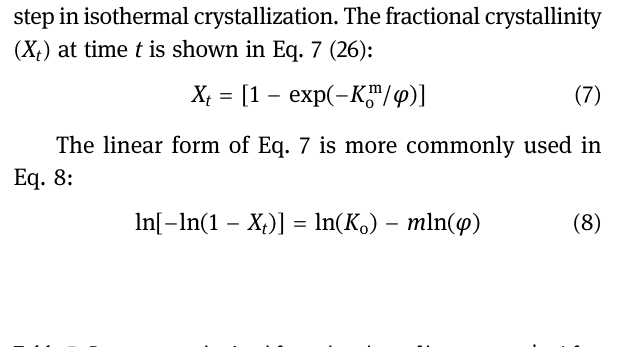
Table 5: Parameters obtained from the plots of φ ln versus t ln for